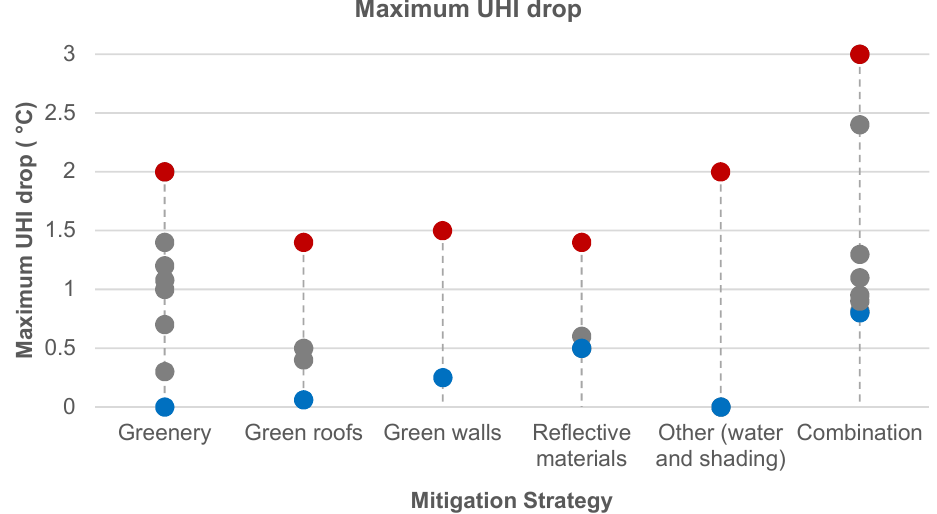
Figure 4. Range of the maximum UHI reduction for all reported mitigation strategies. Blue colour: reported lowest maximum UHI drop value; red colour: reported highest maximum UHI drop value; grey colour: range of maximum UHI drop value between blue and red.